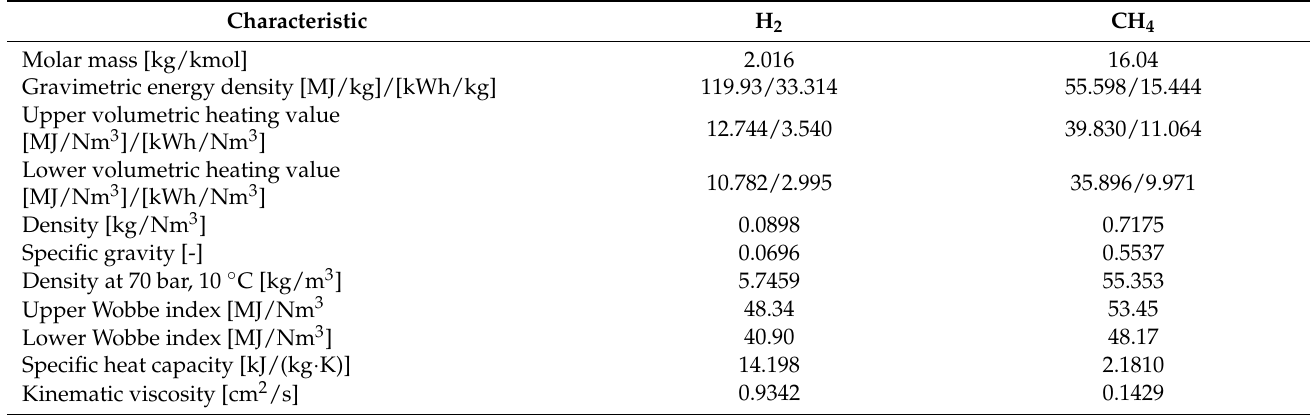
Table 1. Comparison of H 2 and CH 4 characteristics